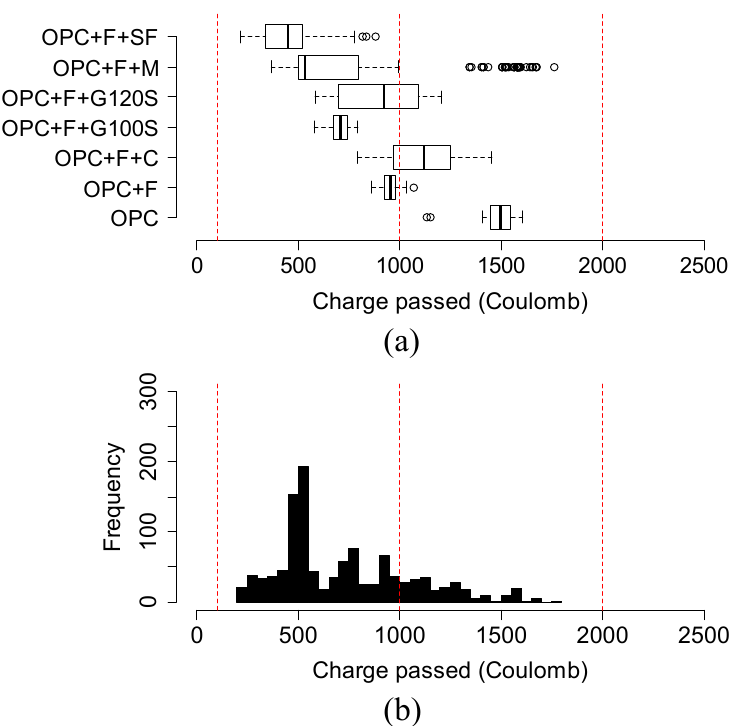
Figure 9. ( a ) Variation and ( b ) distribution of charge passed of Class C fly ash-based mixtures at 91 days. Three vertical red lines in the box plot represent the range of negligible, very low, and low permeability chloride ion permeability class as classified by ASTM C1202 specification.